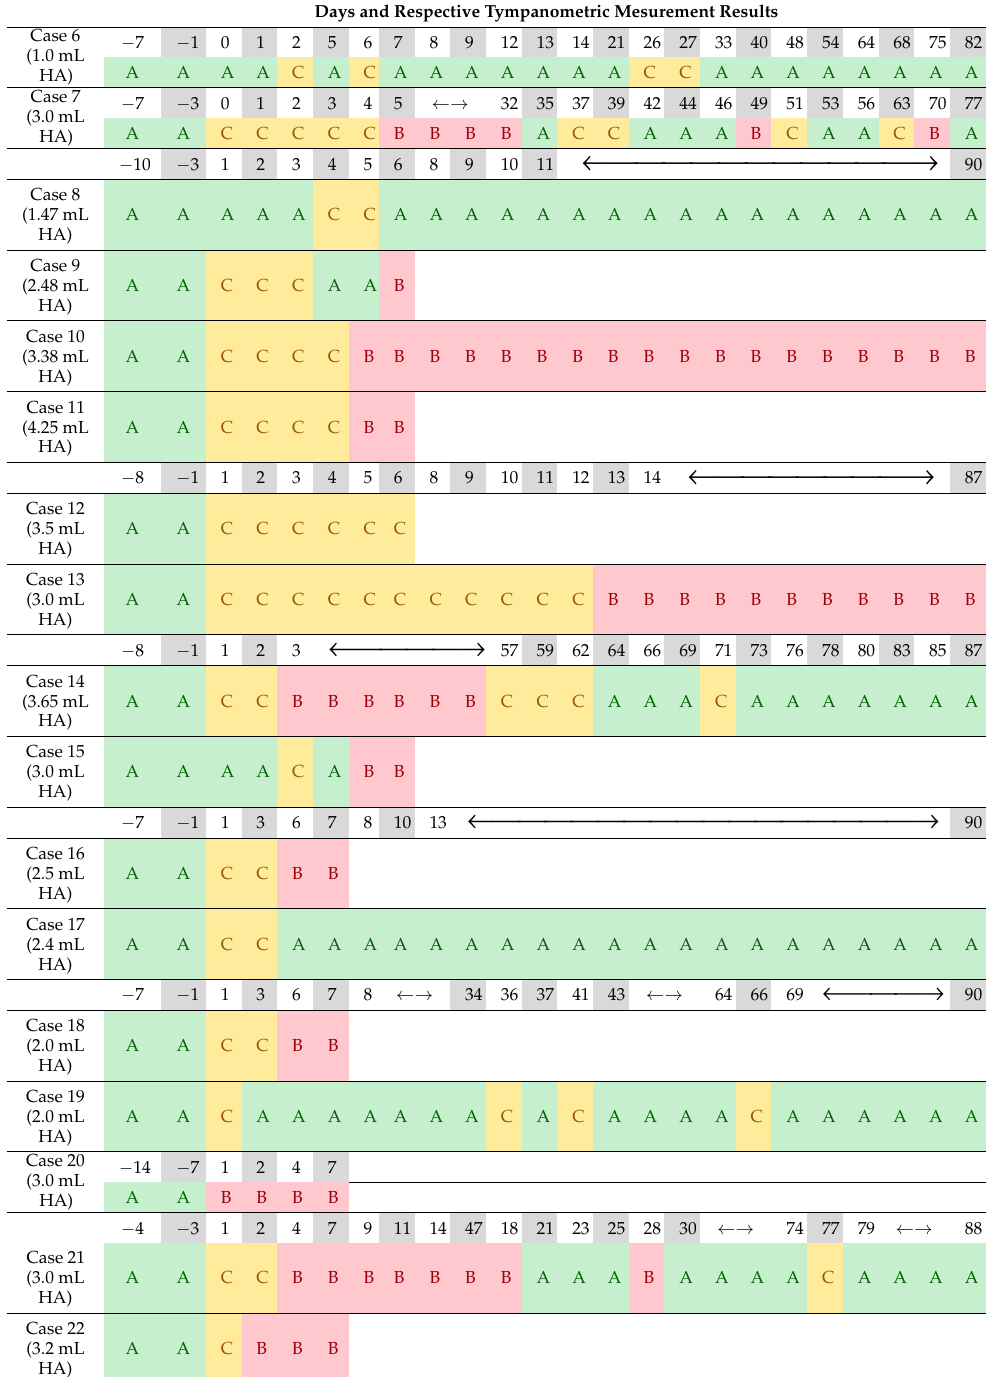
Table 5. Results of tympanometric measurements over the experimental period after injection of stabilized